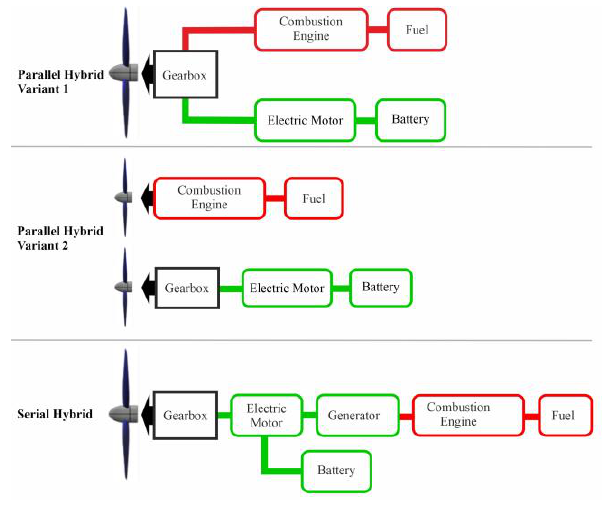
Fig. 2. Schematic diagrams of hybrid propulsion